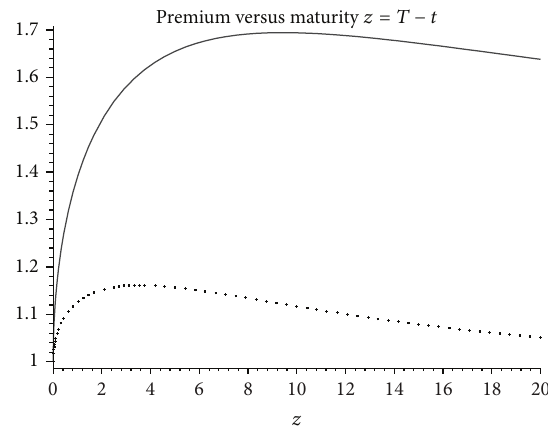
Figure 2: Maturity component premium as a function of time to maturity in years corresponding to benefits Ψ 1) 𝑇 = max {𝑋 𝑇 ,𝑥} and Ψ 1) = max 𝑋 0≤𝑠≤𝑇 𝑠 . The thick dark line is the max-premium (26), 𝑇 whereas (12) is the thin, lower line. Parameters are taken as 𝑥 = 1 , 𝑟 = 0.045 , and 𝜎 = 20